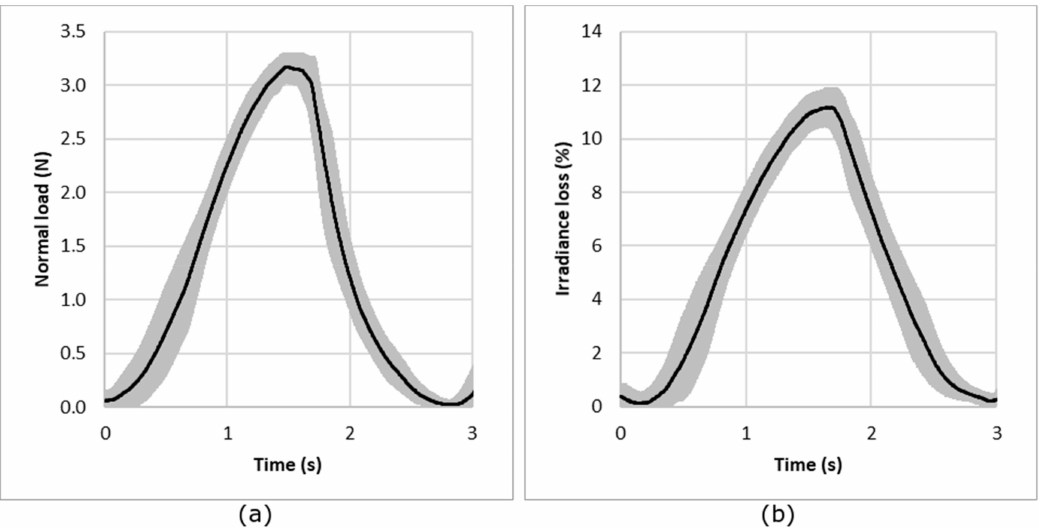
Figure 7. Repeatability of the measurement: evolution of the compression load ( a ) and irradiance loss ( b ) for a compression test (example with single jersey under a nominal load of 3 N). The black line represents the average curve and the gray area the standard deviation.